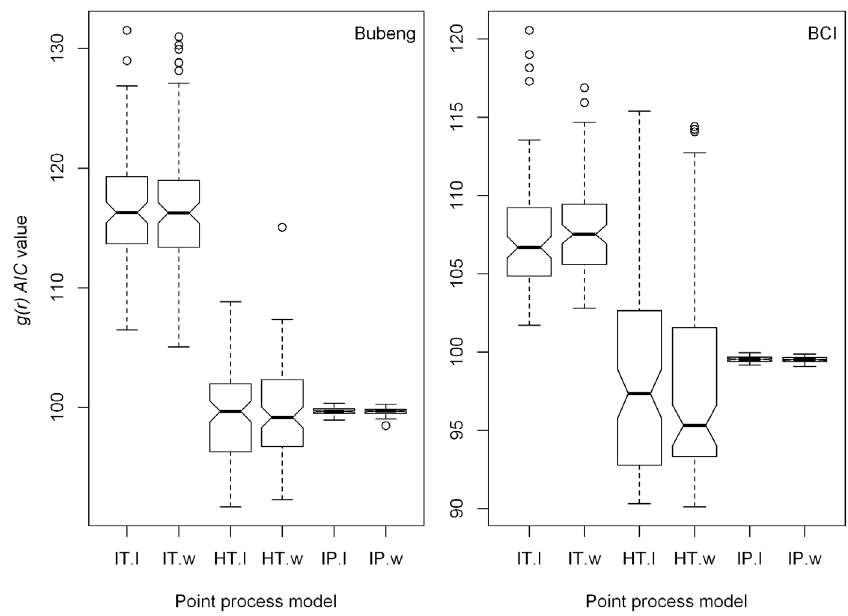
Figure 5. Boxplots of g(r)AIC value distributions generated by the three processe models with and without the size-class effect at Class 0 (that is: size-classes 1, 2 and 3 combined) of the Bubeng plot and the BCI plot.